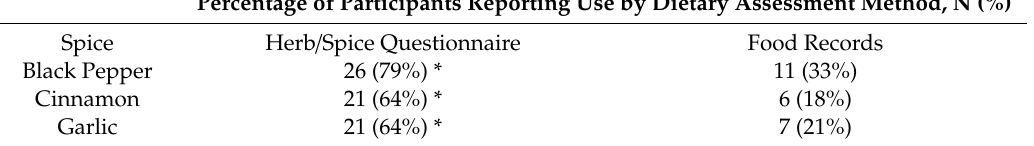
Table 1. Comparison between the herb / spice questionnaire and the food records of reported use of the most commonly consumed herbs and spices.